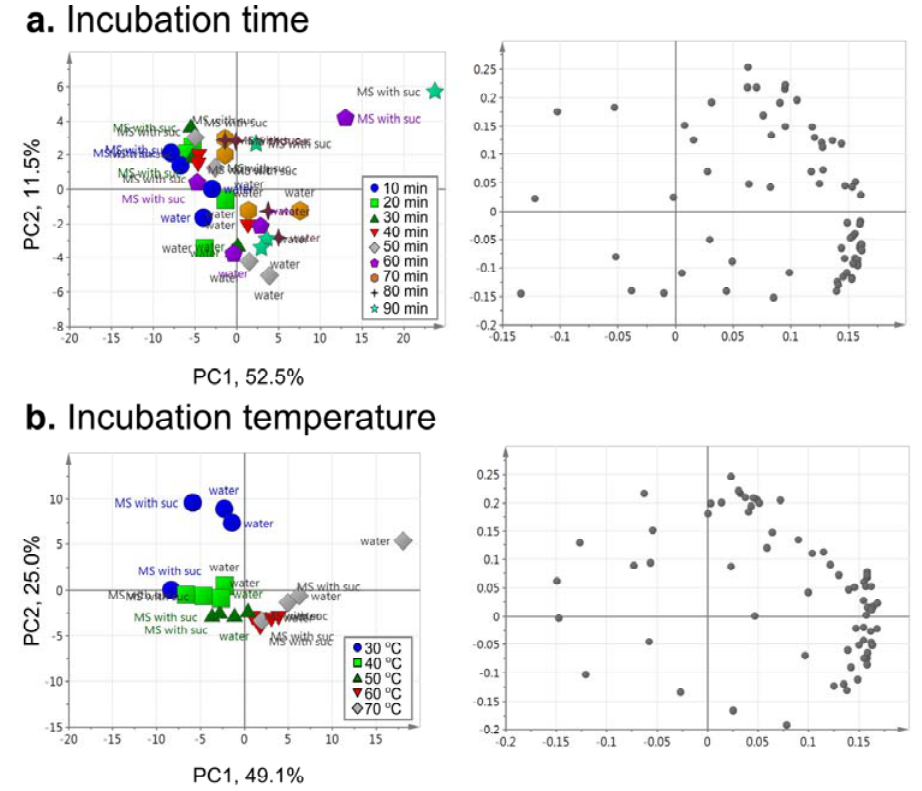
Figure 4. Evaluation of incubation time (a) and temperature (b) to optimize collection efficiency of volatiles in the HS vials containing Arabidopsis seedlings grown in water and MS conditions. Left, PCA score scatter plot. Each symbol represents an independent sample. Right, PCA loading scatter plot. The gray dot shows an annotated peak. Four independent samples (two samples per condition) were analyzed per incubation time or